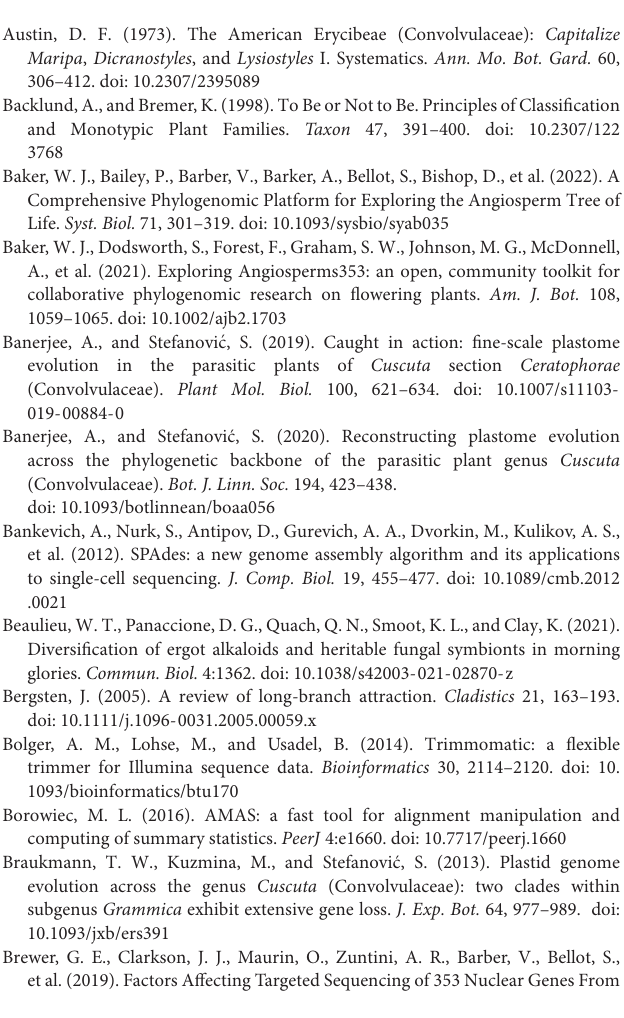
Supplementary Figure 1 | Phylogeny of Convolvulaceae including outgroups from Solanaceae and Montiniaceae. (A) Tree estimated from a concatenated dataset of 349 genes analyzed in IQ-TREE2 with 1000 ultrafast bootstrap replicates. (B) Tree estimated in ASTRAL-III using gene trees from 349 gene trees.